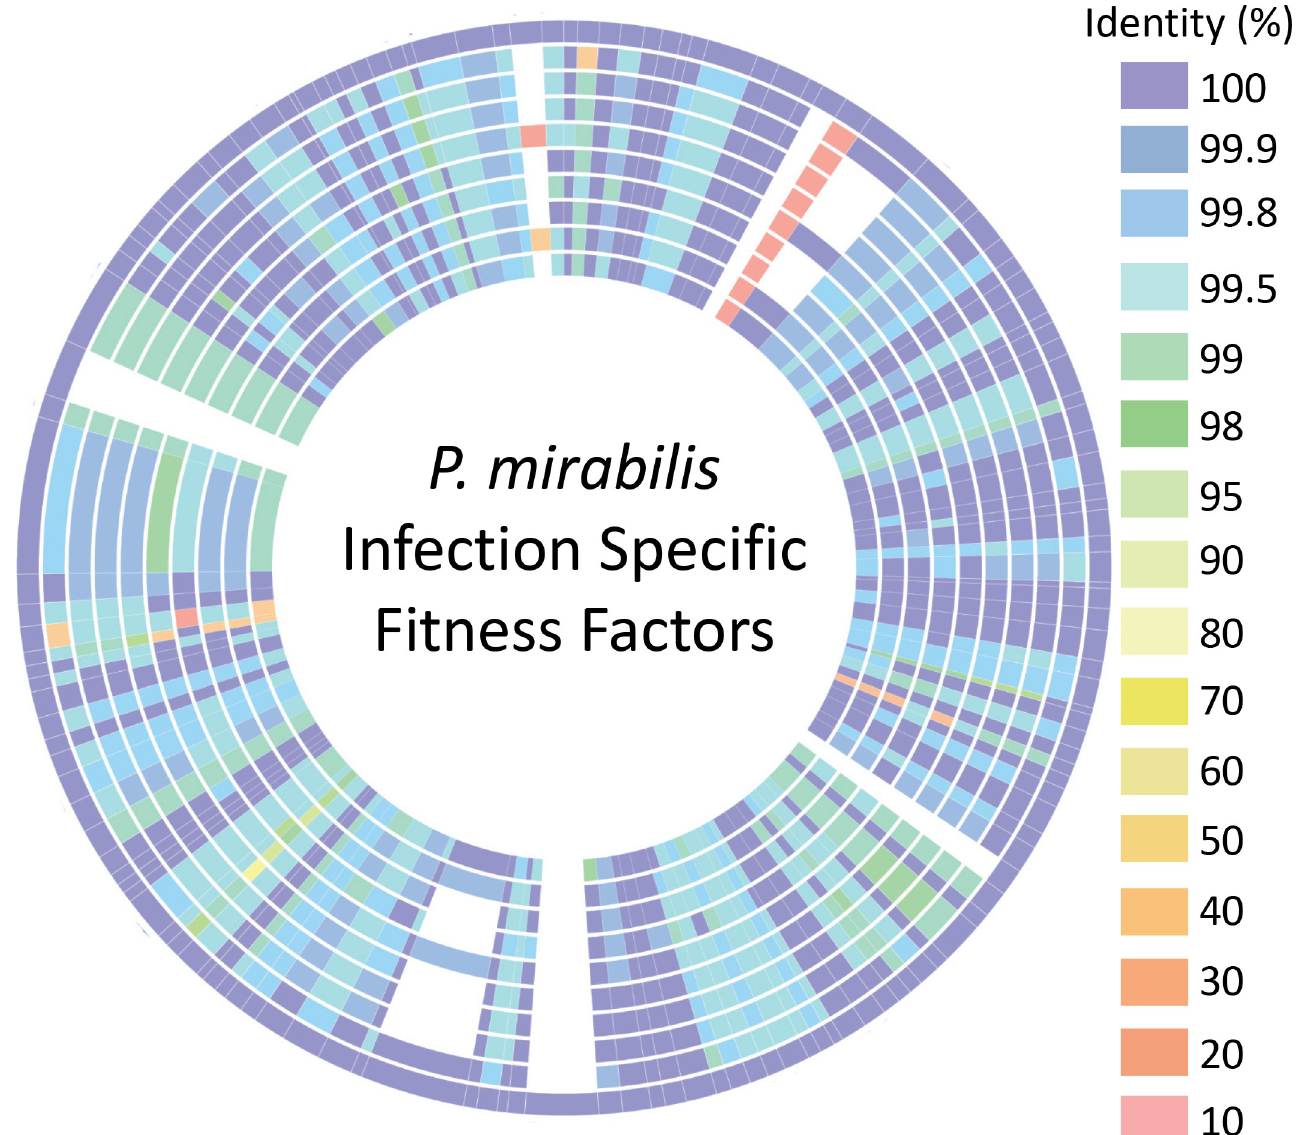
Fig 3. Conservation of infection-specific fitness factors between P. mirabilis isolates. The amino acid sequences available on PATRIC of 143 infection-specific fitness factors identified in P. mirabilis HI4320 were arranged end-to-end on the outer ring and compared to other P. mirabilis proteomes to identify homologs in each of these strains. The level of amino acid sequence identity is indicated by color. Tracks from outside to inside represent the following P. mirabilis isolates: 1) HI4320; 2) AR_0159; 3) PM_125; 4) PM_178; 5) MH13-009N; 6) AOUC-001; 7) NLAE-zl-C285; 8) CYPM1; 9) 1330_PMIR; 10) 429_PMIR.